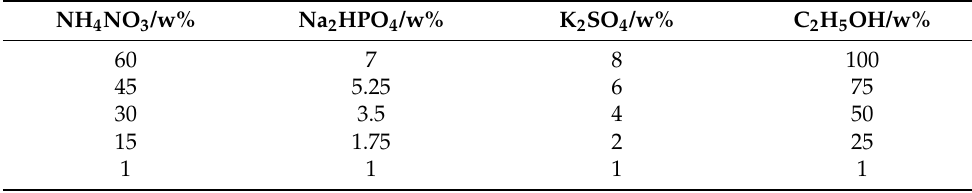
Table 3. Used concentrations of the individual substances dissolved in deionized water.